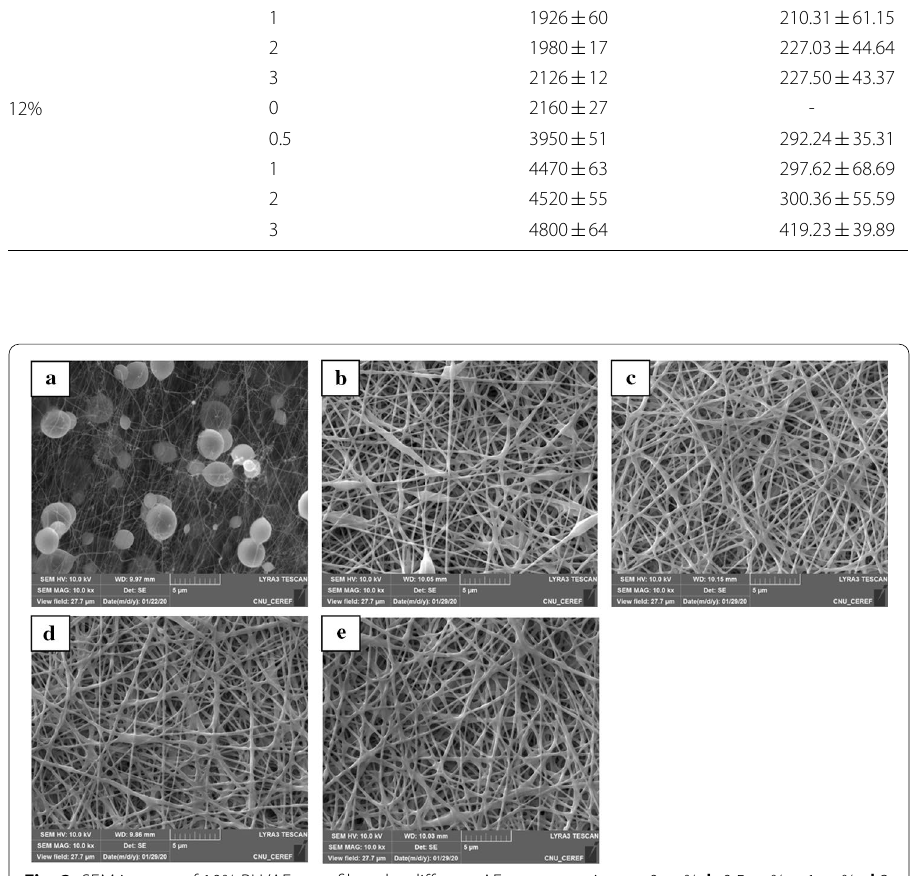
Fig. 2 SEM images of 10% PU/AE nanofibers by different AE concentrations: a 0 wt%, b 0.5 wt%, c 1 wt%, d 2 wt%, and e 3 wt%. (PU solution concentration: 10%, Voltage: 20 kV and TCD:15